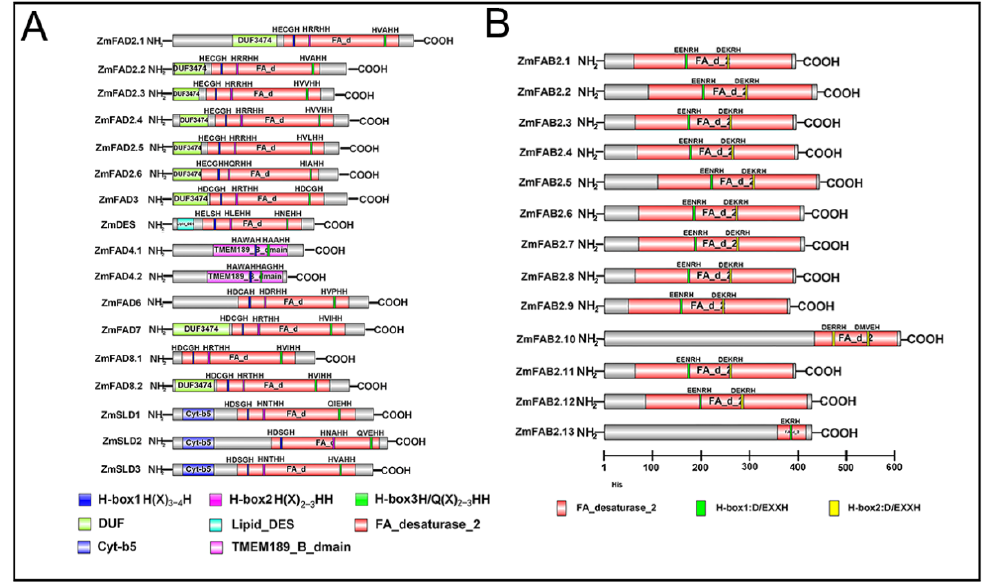
Figure 4. The conserved domains of maize FAD proteins. (A) Membrane-bound FADs; (B) Soluble FAB2s. Predicted signal peptides are shown as colored rectangles. The numbered bar indicates the amino acids.